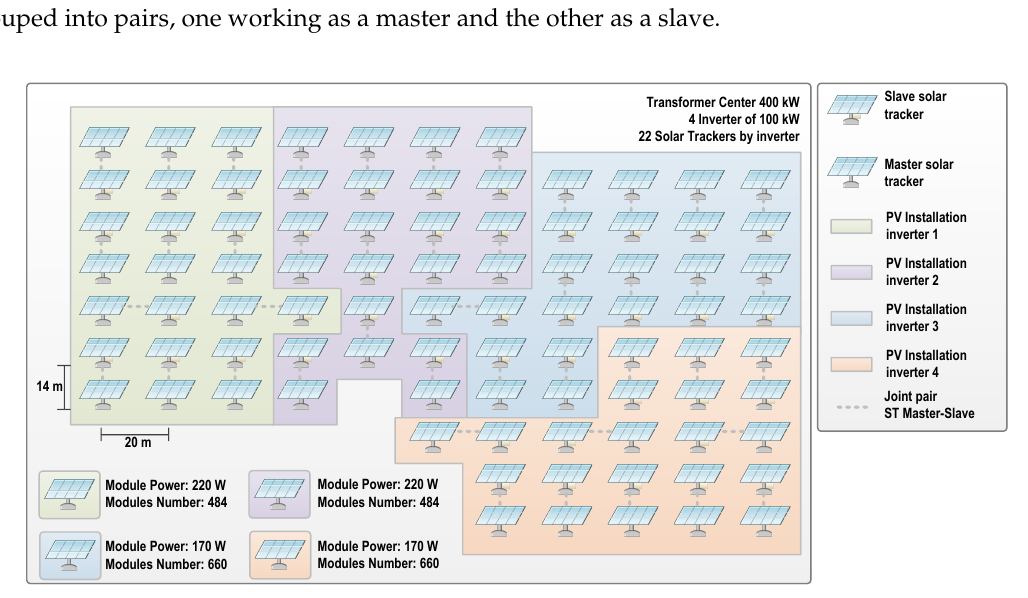
Figure 1. Monitored photovoltaic (PV) modules distribution. ST: Solar Tracker.